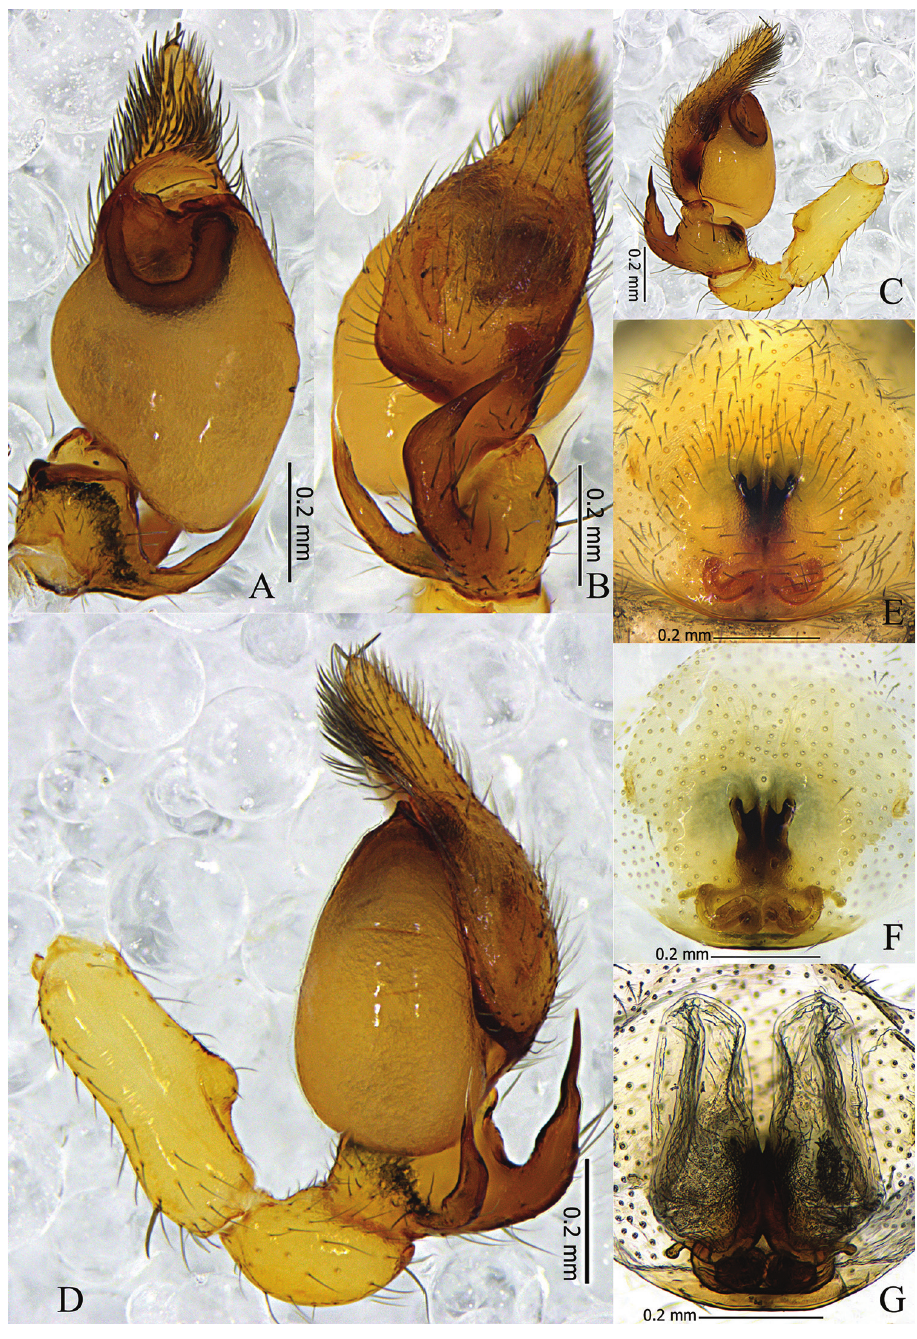
Figure 8. Otacilia curvata sp. n. A left male palp, ventral view B same, dorsal view C same, prolateral view D same, retrolateral view E epigyne, ventral view F same, cleared by potassium hydroxide, ventral view G vulva, dorsal